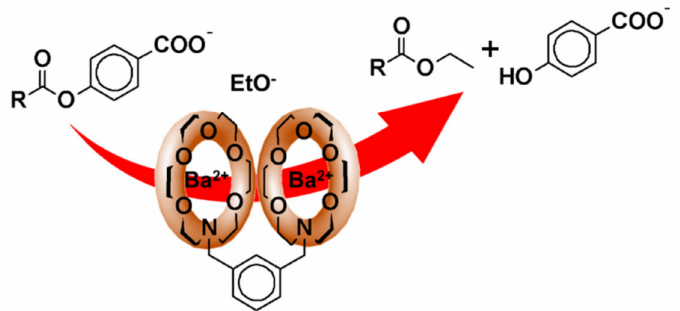
Figure 12. Transesterification by a dinuclear barium